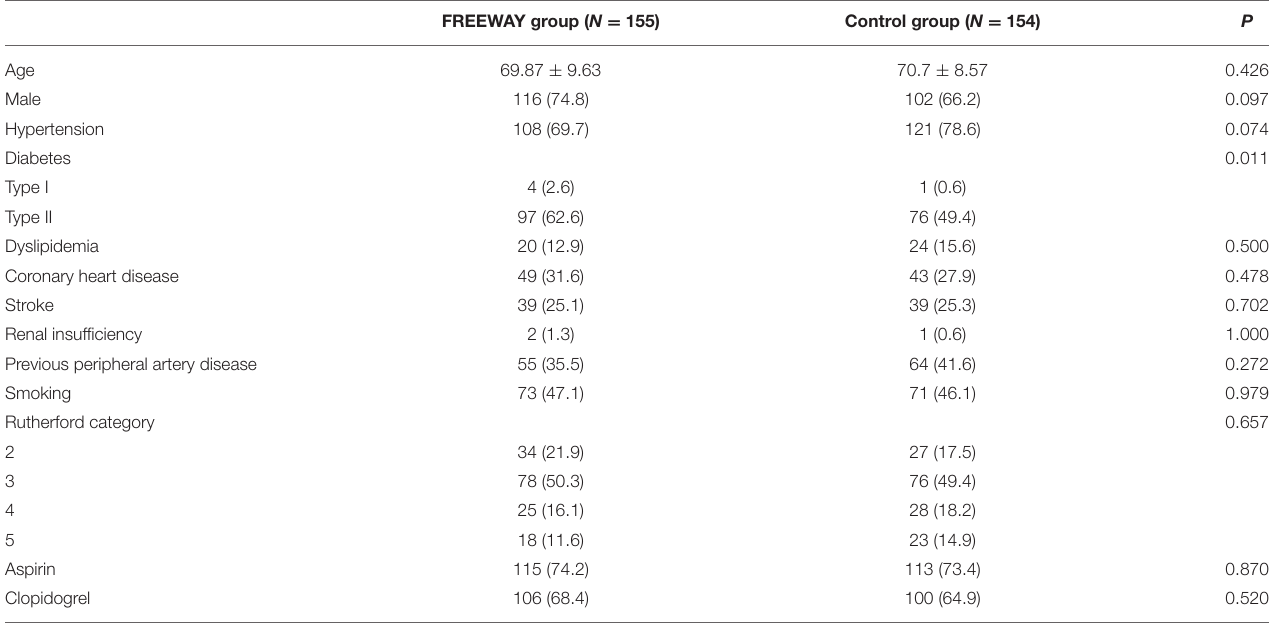
TABLE 1 | Patient